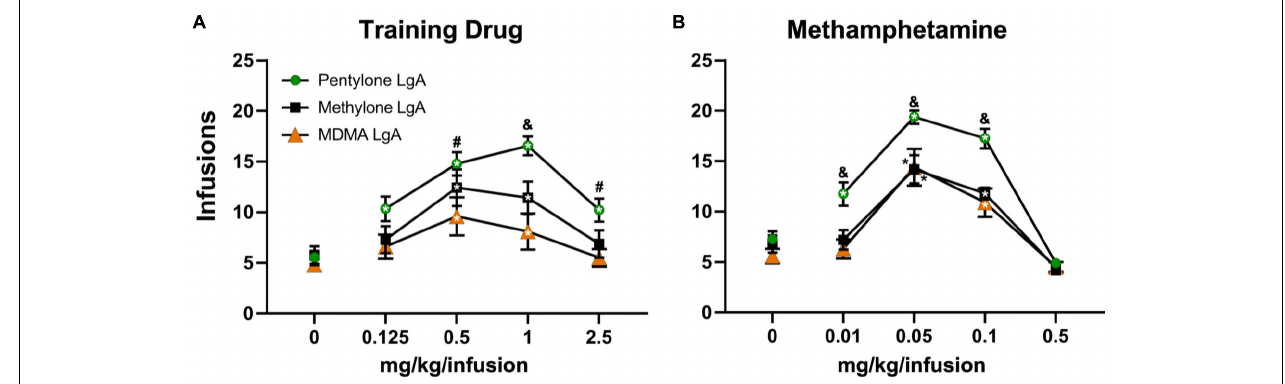
FIGURE 3 | Mean ( ± S.E.M.) infusions of the respective training drug and of methamphetamine obtained by groups trained in LgA- IVSA of pentylone ( N = 8–9), methylone ( N = 5–7), or MDMA ( N = 10) are illustrated. A significant difference from saline, within group, is indicated with * (both inside and outside symbol), a significant difference from both other groups with &, and a difference from the MDMA LgA group with #.